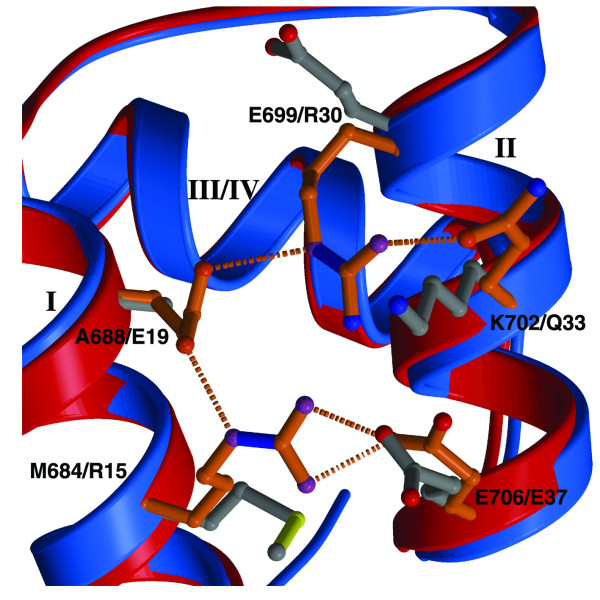
Comparison of a region of engrailed HD and ZHX1 HD4 containing certain co-variant residues. Engrailed HD (blue backbone, orange side-chains) showing the extensive ionic and hydrogen-bonding interactions involving commonly observed co-variant residues. These interactions are absent in ZHX1 HD4 (red backbone, gray side-chains).